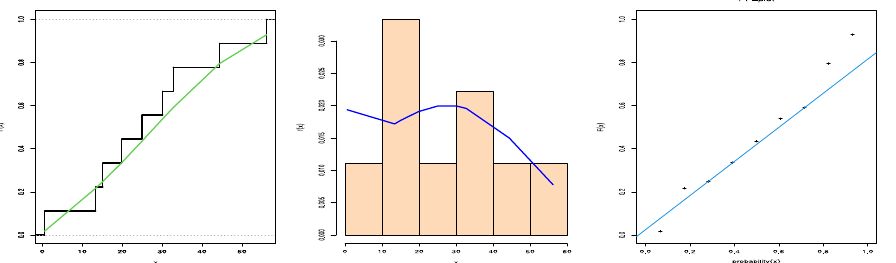
Figure 2. Plots of empirical cdf, histogram, and PP plots for the WE